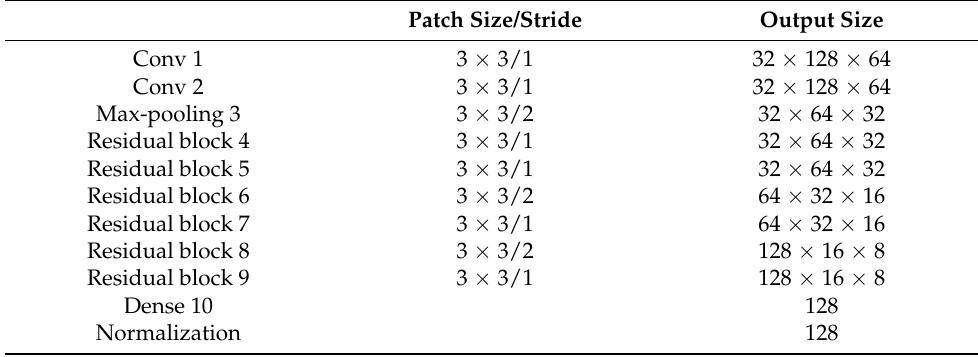
Table 1. The CNN Table 1. The CNN architecture.